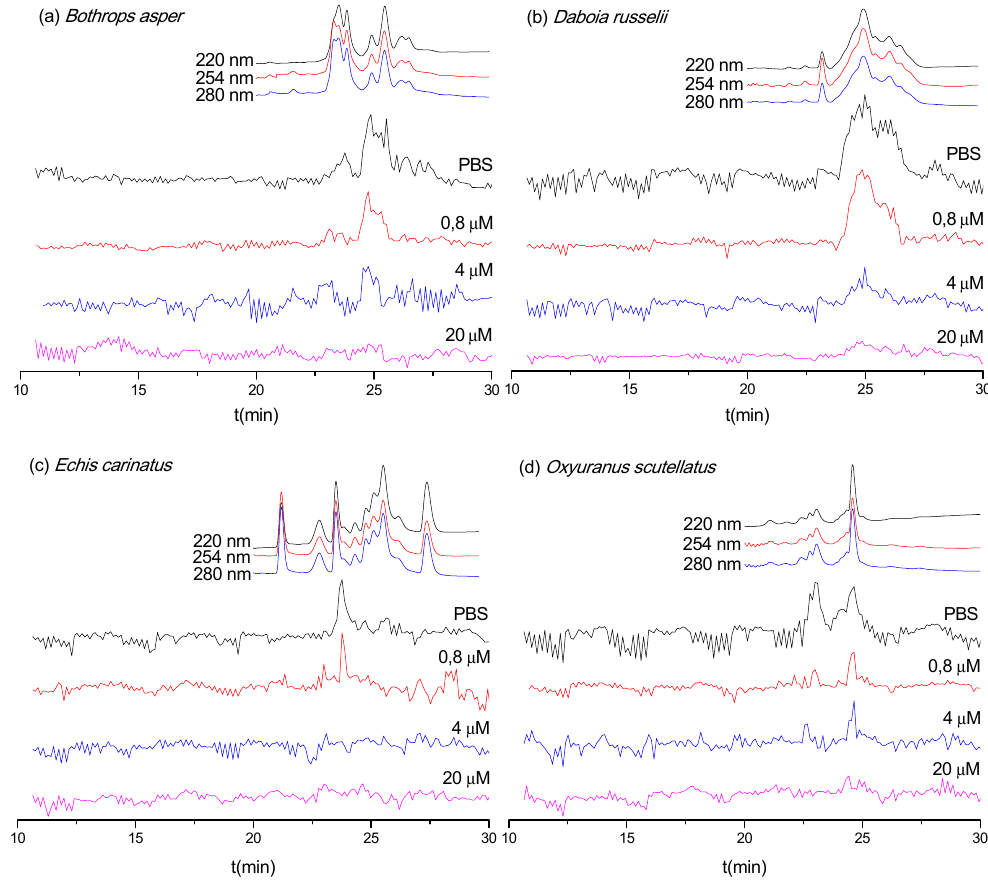
Figure 3. Superimposed PLA 2 bioactivity chromatograms for nanofractionated venom toxins measured in the presence of the indicated concentrations of varespladib: ( a ) B. asper , ( b ) D. russelii , ( c ) E. carinatus, and ( d ) O. scutellatus . Top traces are the online LC-UV chromatograms recorded at 220, 254, and 280 nm for the respective venoms (allowing a correlation with LC-MS and proteomics data from Slagboom et al. [33] ).